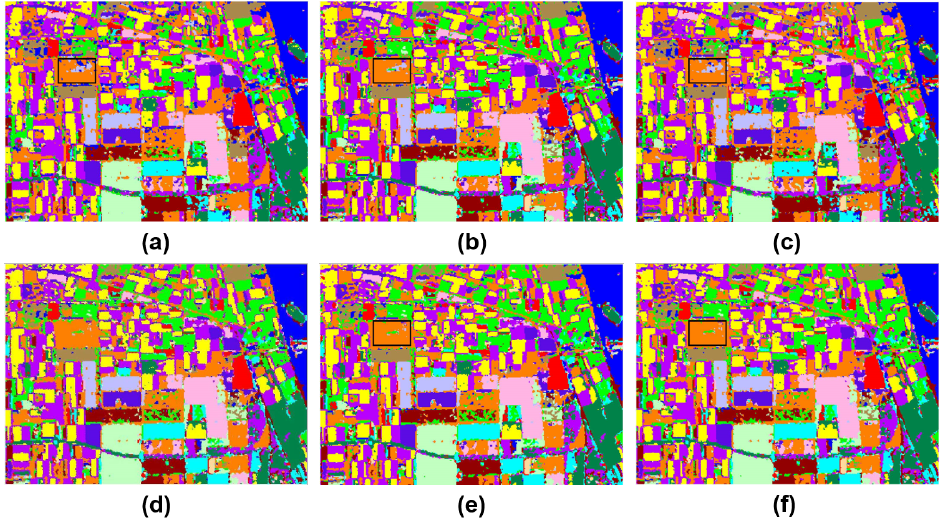
Figure 24. The classification results of our algorithms and compared algorithms ( a ) WAE [293] ( b ) WCAE [293] ( c ) RV-CAE ( d ) FFS-CNN [292] ( e ) CV-CAE [140] ( f ) CV-CAE+SPF